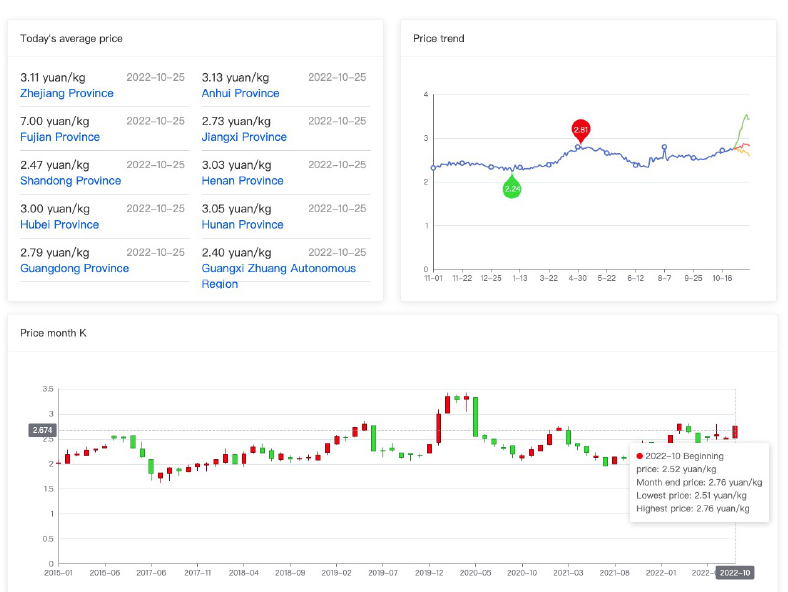
Figure 6. Monthly K chart of the national wholesale potato market prices (www.tudouec.com, accessded on 25 October